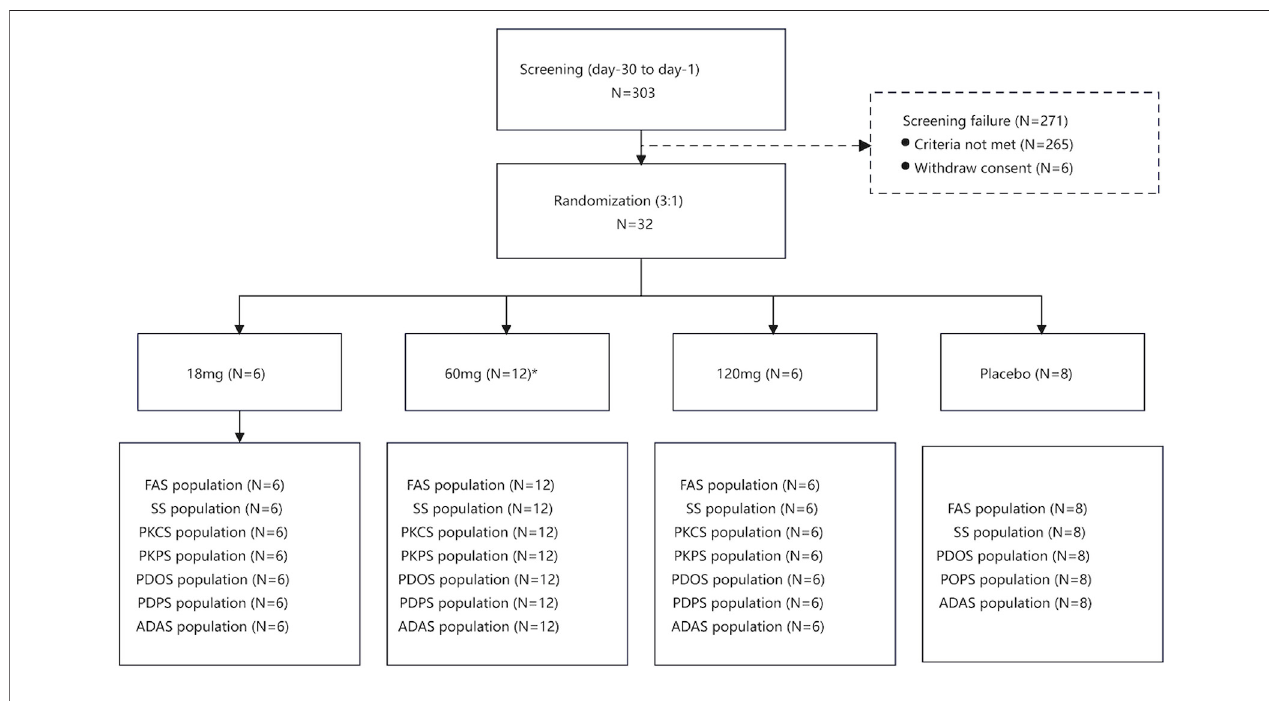
FIGURE 1 | Flow chart of the study.